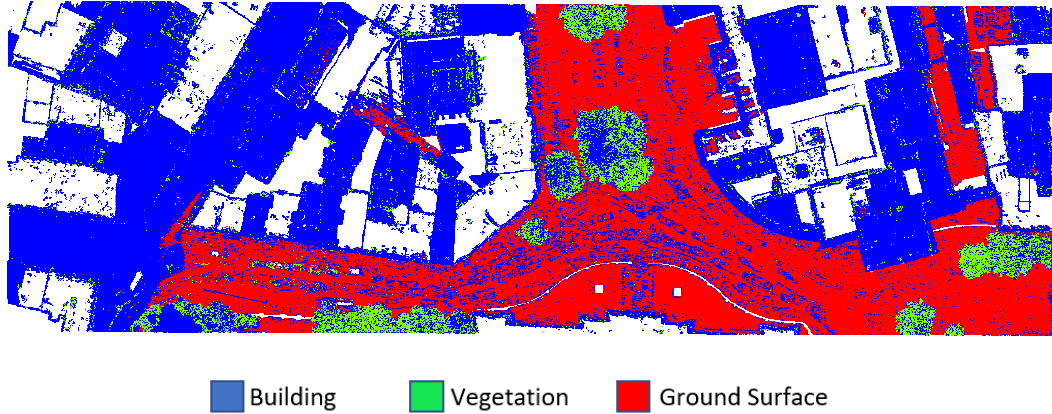
Figure 7. The best classified point cloud from Dublin City Area 2 (MLP with R 3 ).